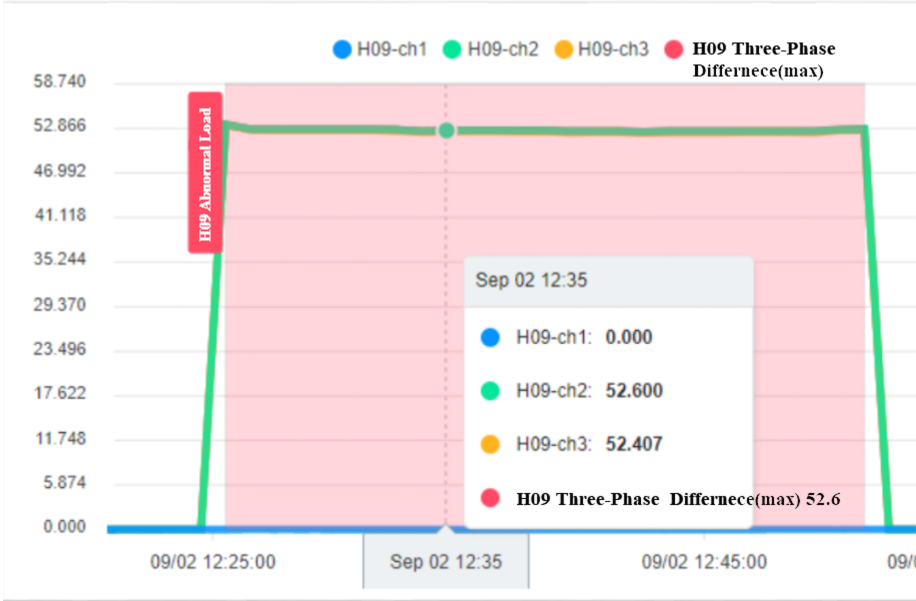
Figure 11. Visualization system.